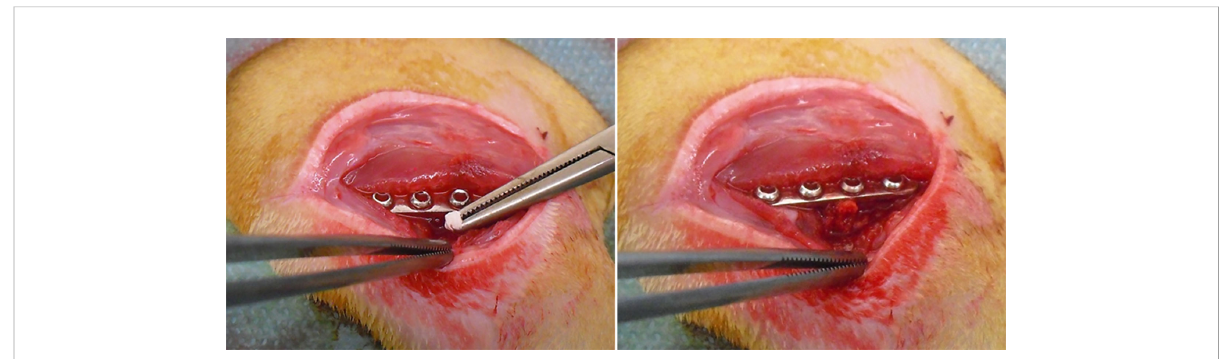
FIGURE 2 AFN-PSF treatment. Vancomycin-loaded functionalized PSF sponge (AFN-PSF) is placed into the fracture site after the fracture